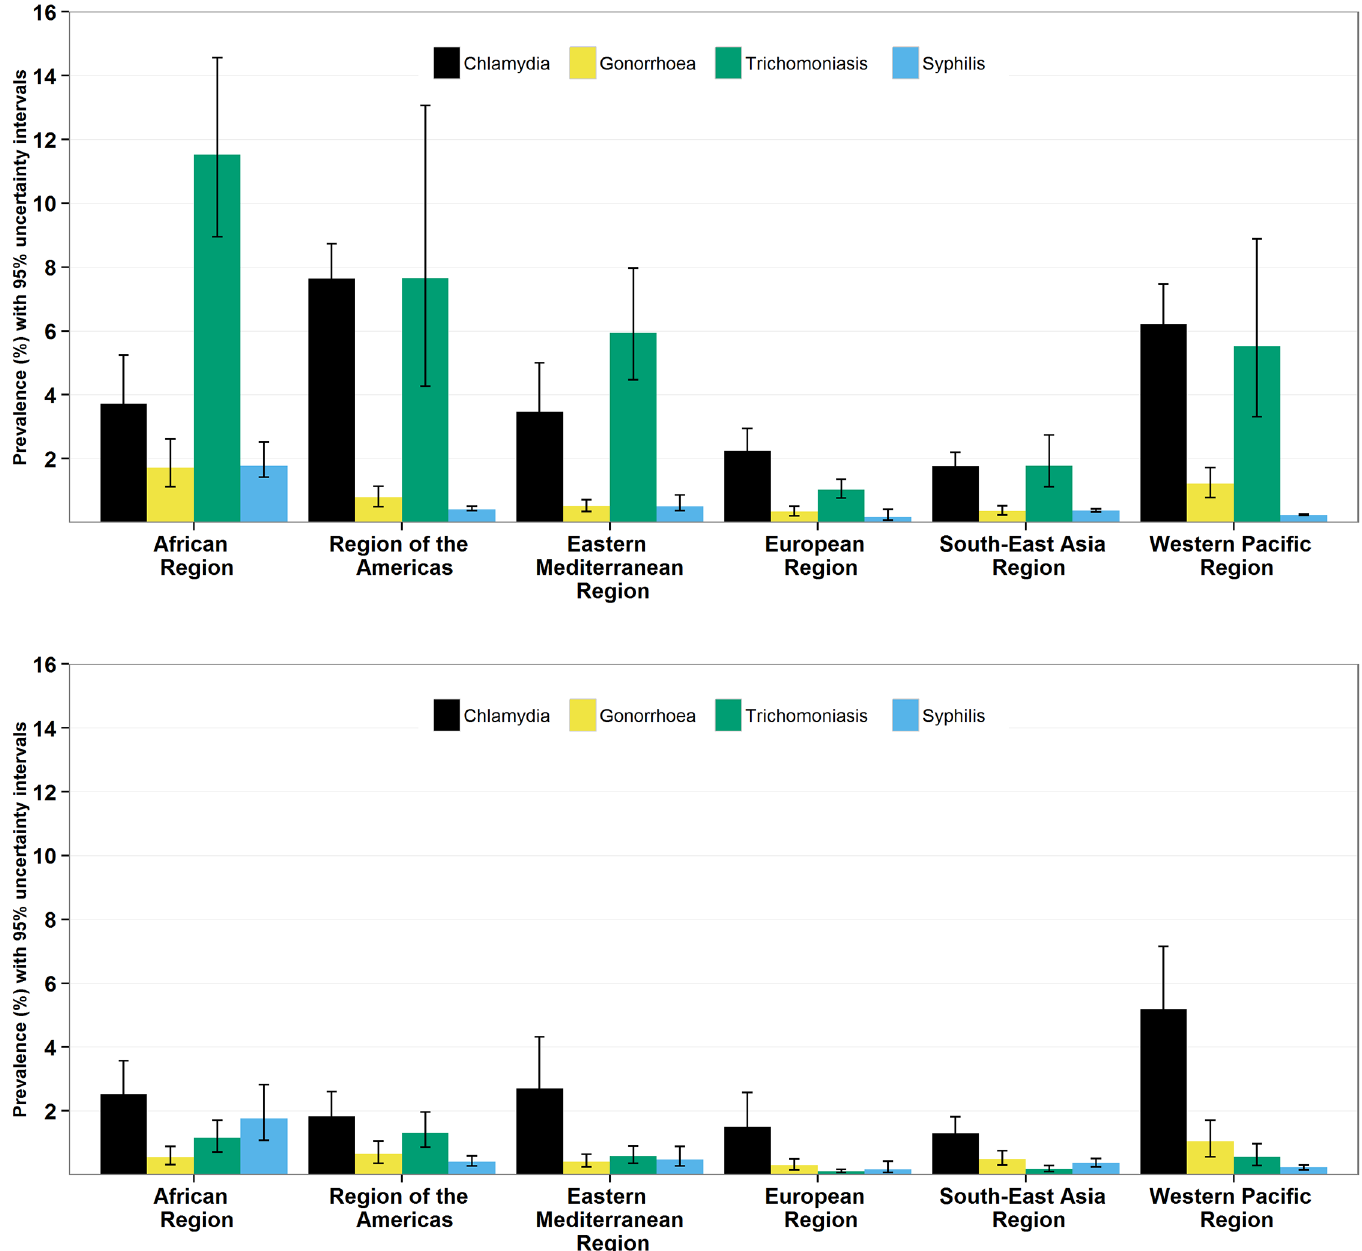
Fig 2. Estimated prevalence (and 95% UI) of chlamydia, gonorrhoea, trichomoniasis, and syphilis in women and men aged 15 – 49 years by WHO region, based on 2005 – 2012 data.